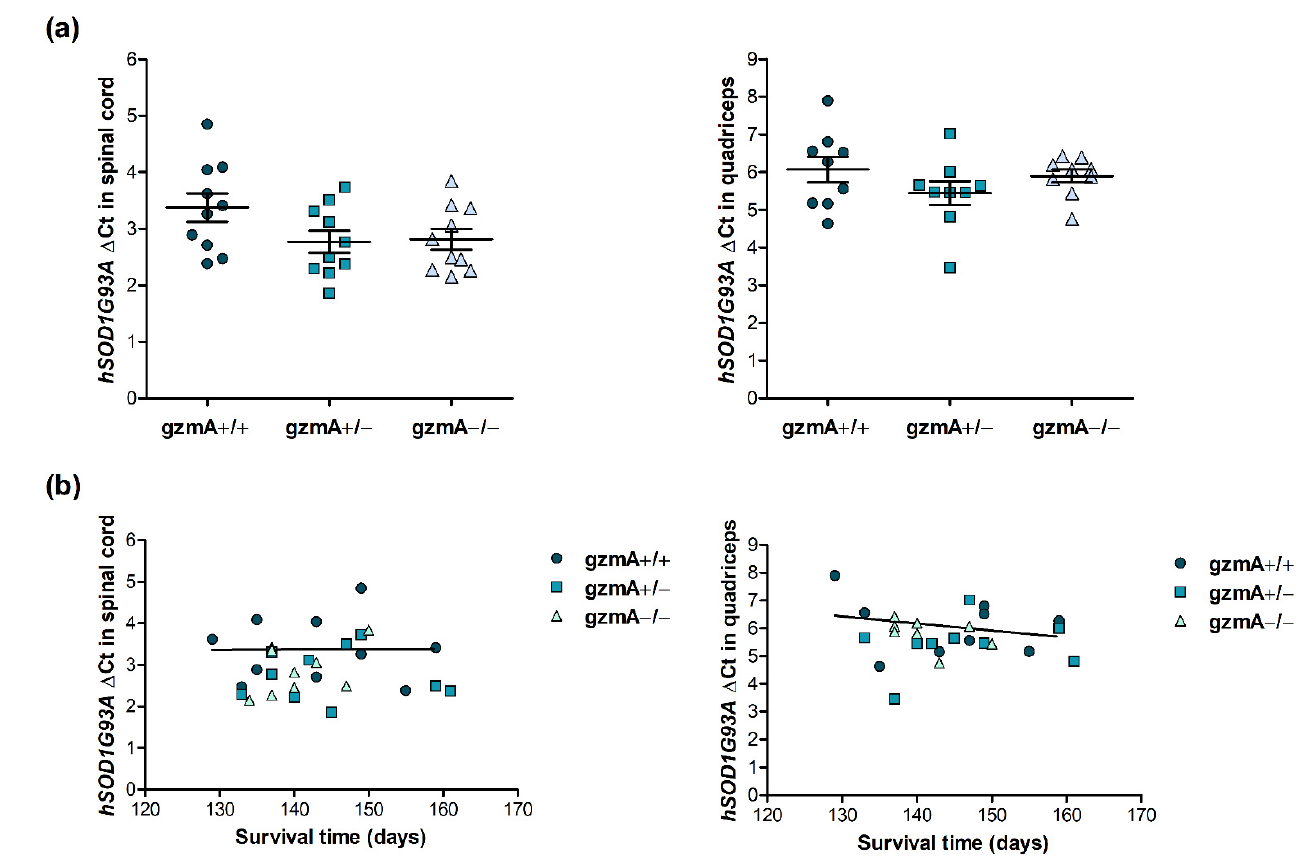
Figure 2. hSOD1G93A expression in spinal cord and quadriceps of gzmA+/+, gzmA+/ − and gzmA − / − mice involved in the survival assay. ( a ) Expression of hSOD1G93A was quantified in both tissues from 10 gmzA+/+, 10 gzmA+/ − and 10 gzmA − / − mice. No differences between genotypes were found ( p > 0.05). ( b ) Correlations between hSOD1G93A expression and survival time were not statistically significant (r 2 = 0.0000884, p = 0.979 in spinal cord, r 2 = 0.0649, p = 0.508 in quadriceps).